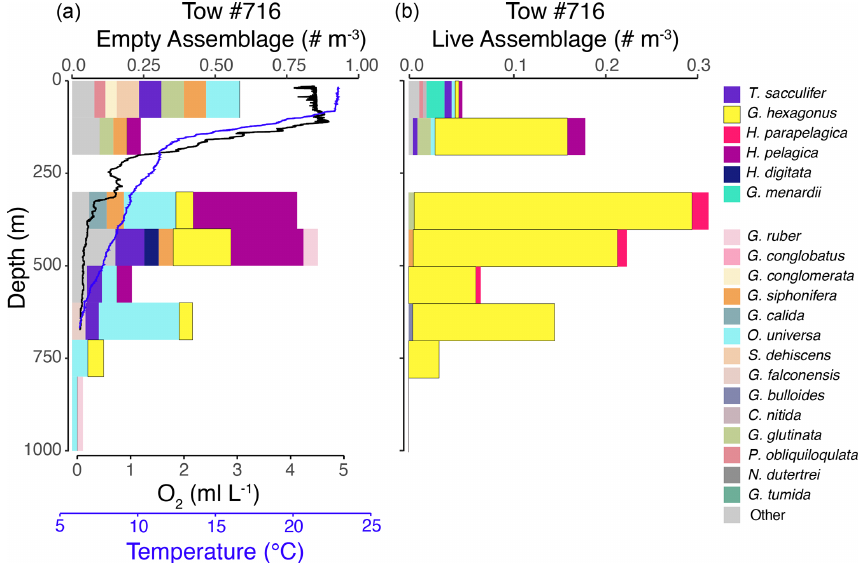
Figure 3. Vertical profiles of the empty assemblage, dissolved oxygen, and temperature (a) and live foraminiferal assemblage (b) from tow no. 716 (0–1000m). Each color represents a different species (see legend), with brighter colors for the six most salient species across nets and depths. Note that the abundance axes vary between panels.